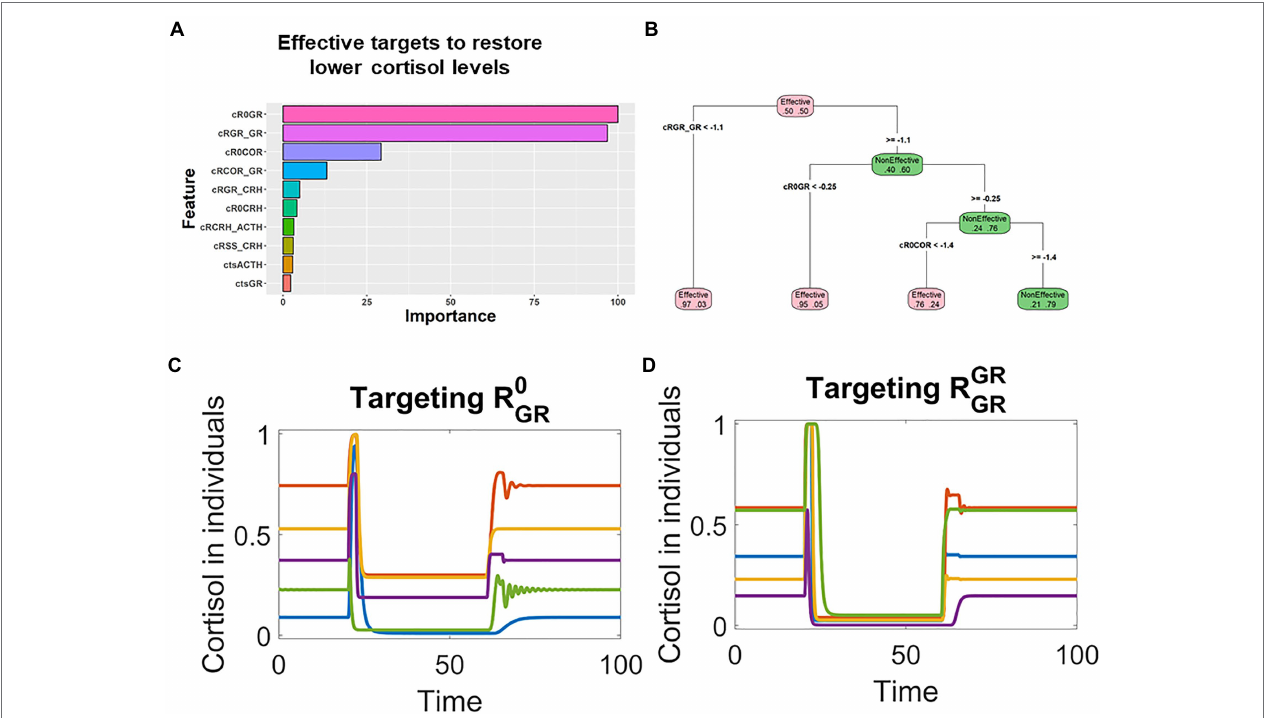
FIGURE 4 | Machine learning analysis revealed that the key parameters controlling the GR positive feedback were associated with effective treatments for patients with lower cortisol levels. (A) . Random forest analysis ranked the targets based on their association with the effective treatments in patients whose pathological cortisol levels were lower. (B) . Decision tree analysis indicated that these parameters were decreased in effective treatments. (C,D) Time series simulations illustrated how the decrease of 0 R GR or R GR GR restored the cortisol levels in patients with lower pathological cortisol